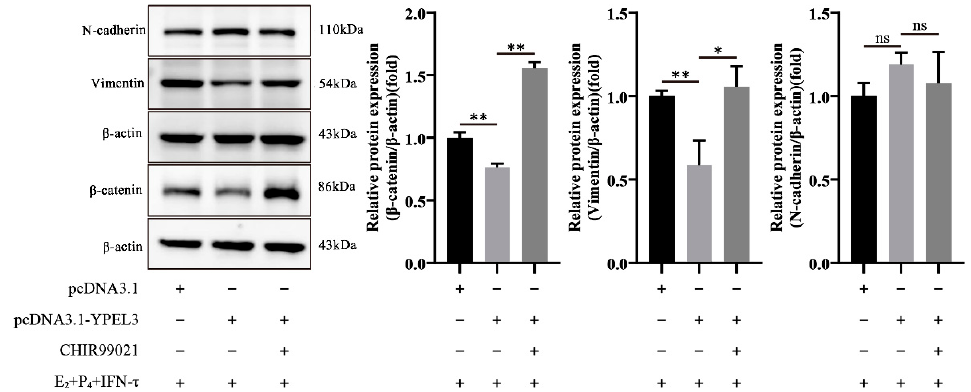
Figure 6. The effect of β -catenin activation on gEEC EMT. Western blot analysis of the expression of EMT markers (N-cadherin, vimentin) and β -catenin proteins in gEECs pre-treated with 5 µ M CHIR99021 before E 2 , P 4 and IFN- τ treatment. * p < 0.05, ** p < 0.01, ns, not significant ( p > 0.05).